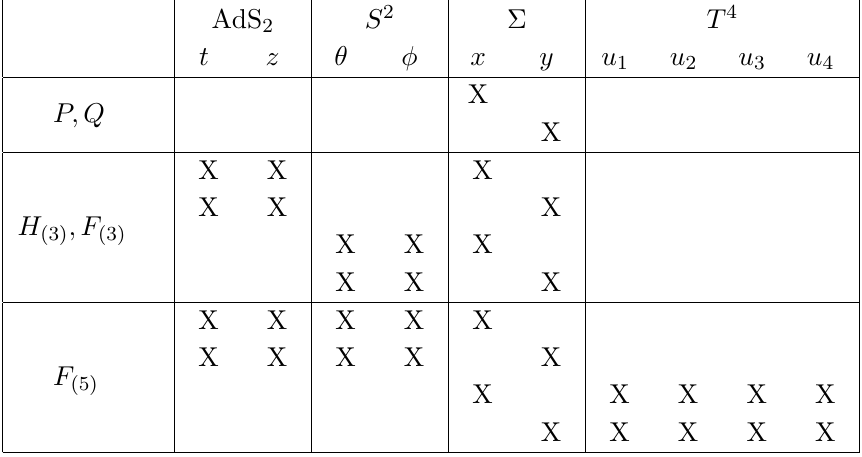
Table 1 . List of nonzero components of the (cid:12)ve- and three-form (cid:13)uxes and of the axion-dilaton composite (cid:12)eld strength and connection for general ten-dimensional Janus and string-junction so-